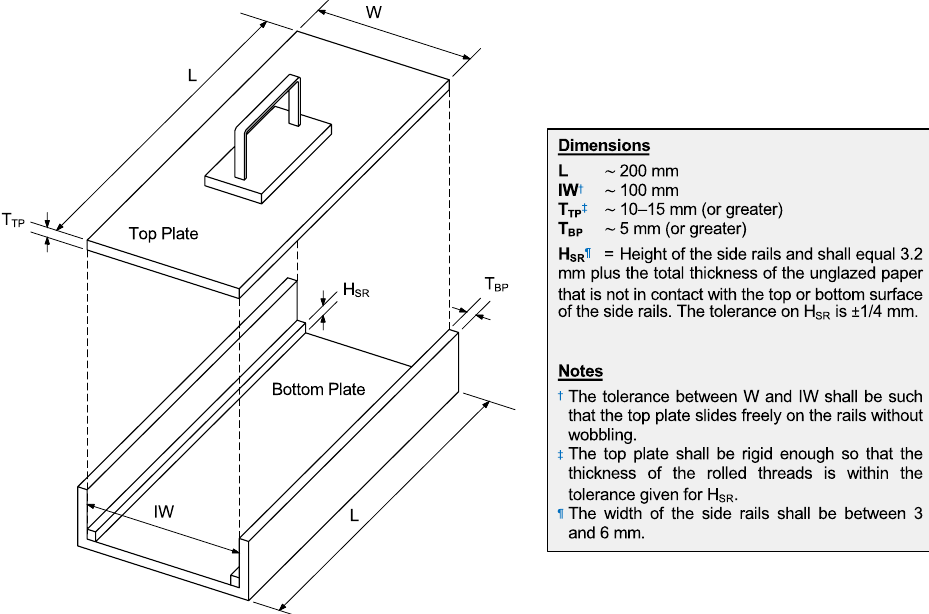
Figure 1. Schematic illustration of the ASTM/AASHTO rolling device for PL determination (modified from [30]).